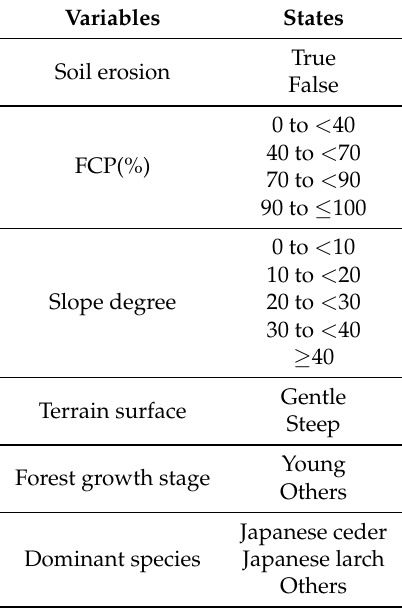
Figure 2. Structure of the Bayesian network model used to estimate the possibility of soil erosion. Table 2. Variables and states used for the model to reveal the influence of regional forest management on individual forestry